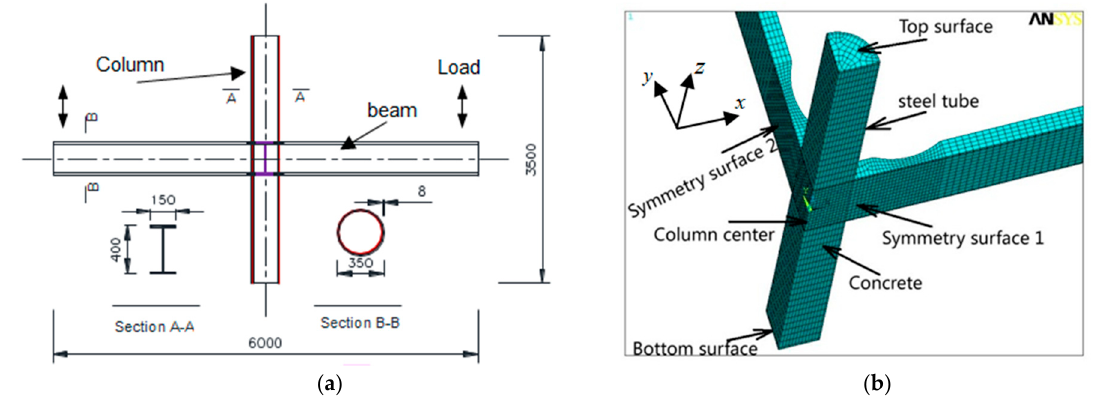
Figure 2. Joint dimensions and boundary conditions. ( a ) Configuration of joints, ( b ) Boundary conditions.